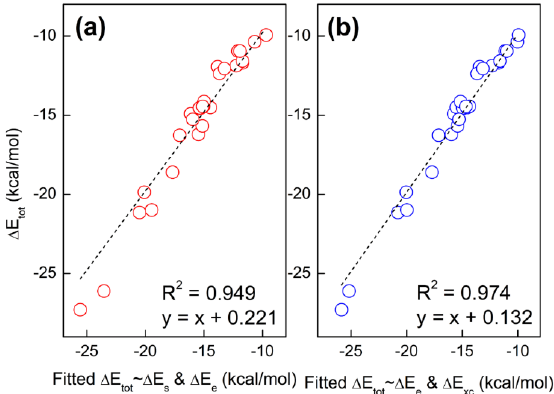
Figure 2. Two-variable fit of the total energy difference ( Δ E tot ) with ( a ) steric hindrance ( Δ E s ) and electrostatic potential ( Δ E e ) and ( b ) electrostatic potential ( Δ E s ) and exchange-correlation effect ( Δ E xc ).